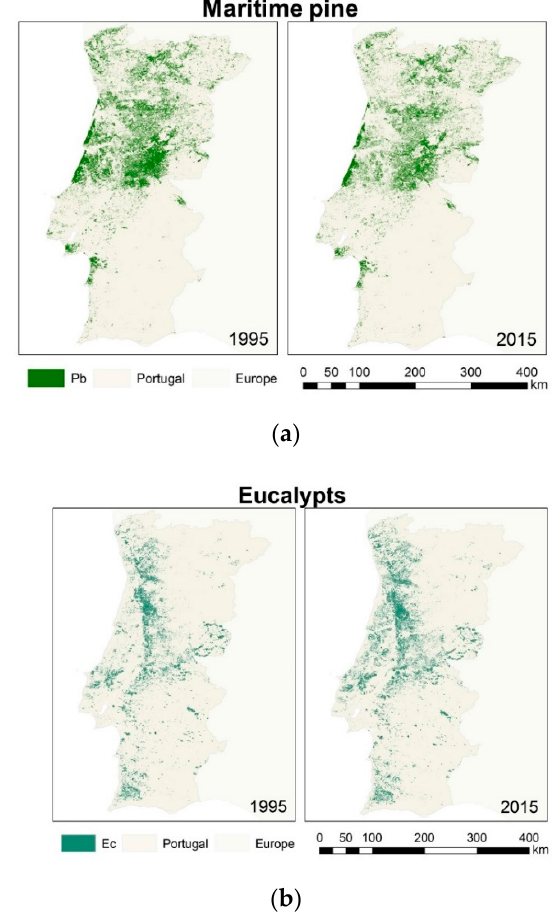
Figure 1. Study area—Forest cover in 1995 (COS1995) and 2015 (COS2015): ( a ) Maritime pine (Pb); ( b ) Eucalypts